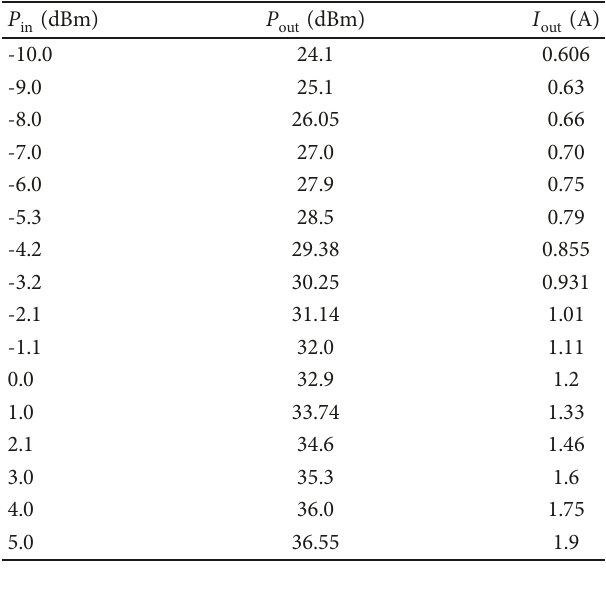
Table 2: PA, input vs. output power, and output